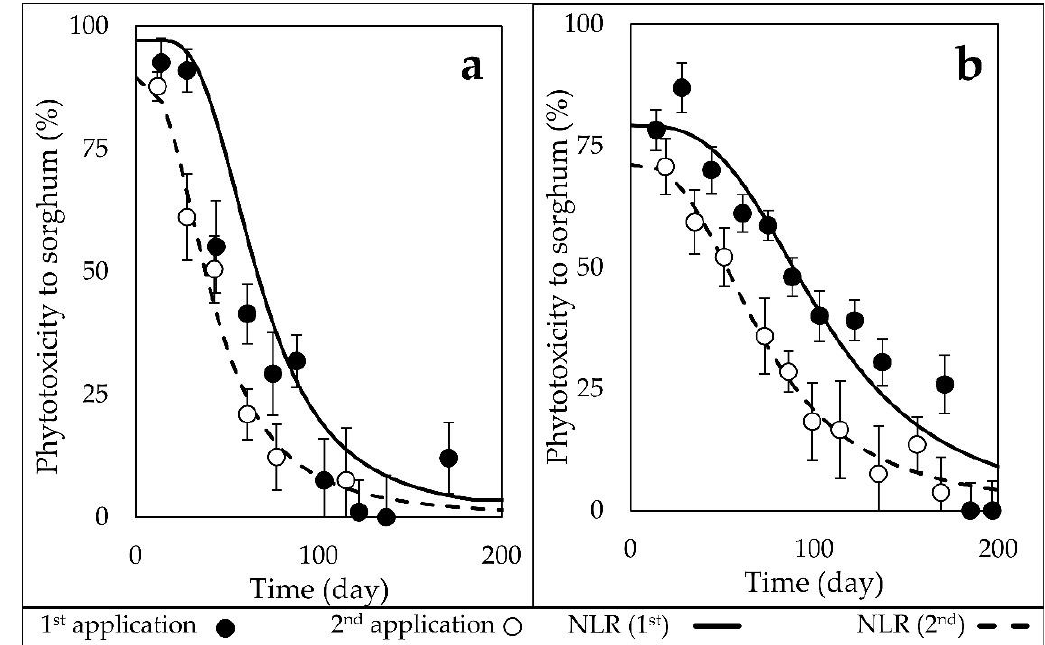
Figure 1. The effect of repeated sulfosulfuron application on the dynamics of its residual activity in soil from H. Eden ( a ) and Kalanit ( b ), as measured by sorghum root elongation. Sorghum root length was measured four days after sowing, and phytotoxicity was calculated using Equation (1). Results of the first sulfosulfuron application were presented in a previous publication [9]. A second sulfosulfuron application was performed immediately after termination of the first application experiment, and a non-linear regression was fitted to the data (Table S2). Error bars represent the standard error ( n = 10). NLR = Non-linear